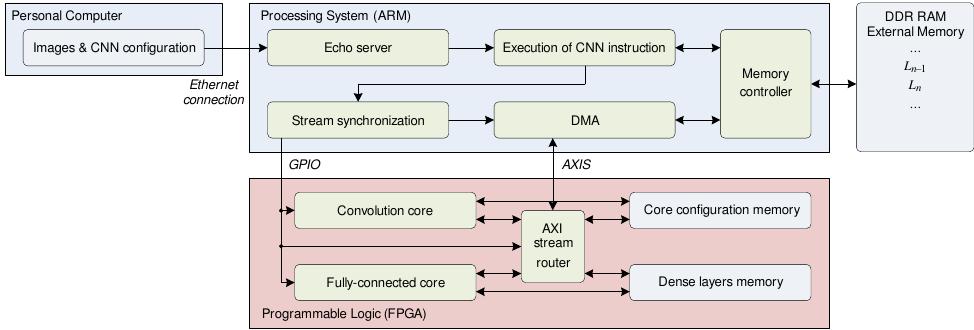
Figure 5. Top-level architecture of the CNN accelerator.